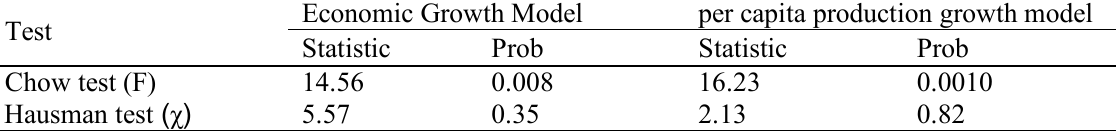
Table 4 . Results of test Estimate panel patterns in Developing countries Test